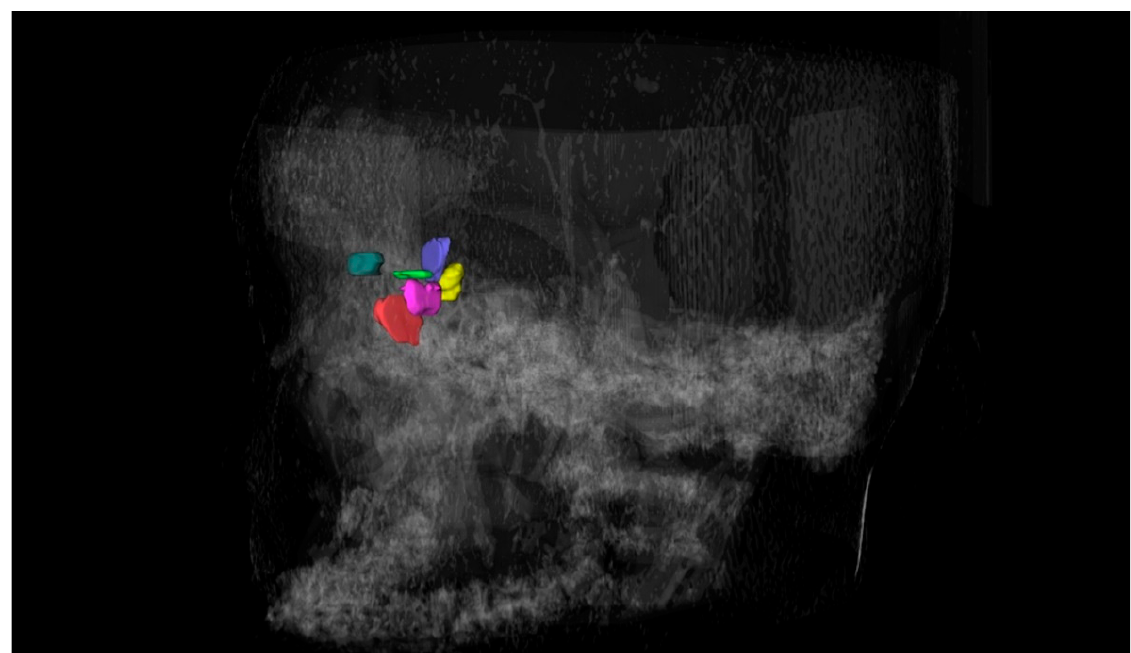
Figure 2. Three-dimensional reconstruction of the frontal ethmoidal cells.